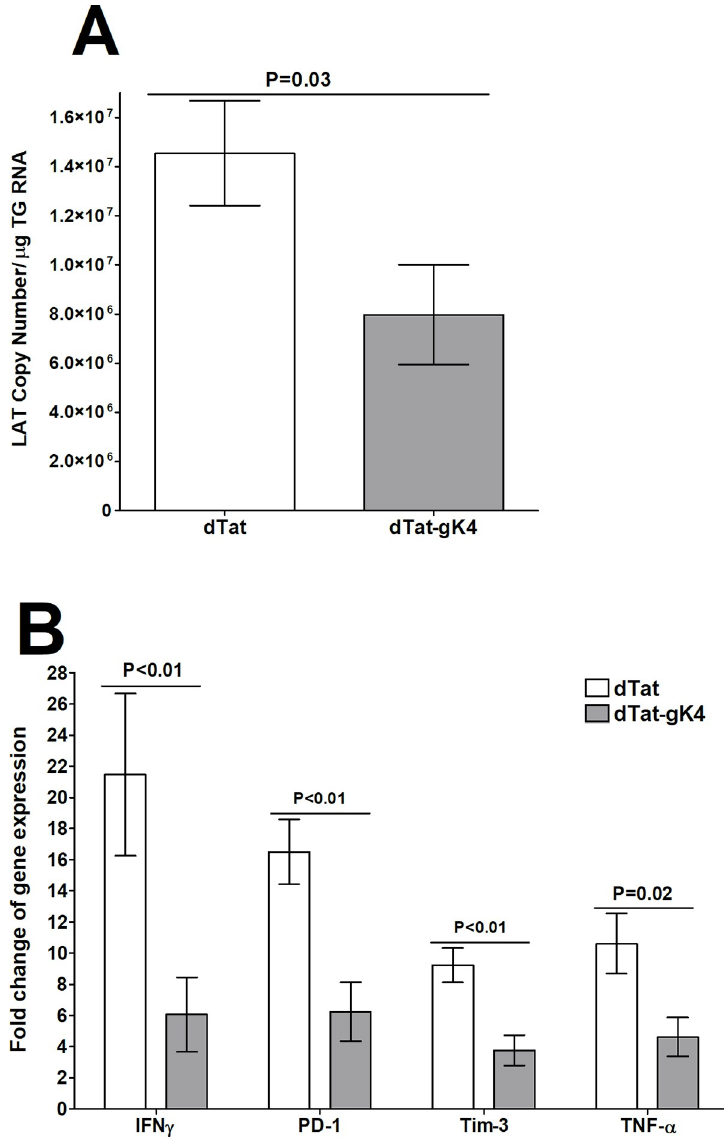
Fig 10. Effect of dTat-gK4 peptide on latency and exhaustion marker levels in C57BL/6 infected mice. TG from mice described in Fig 9 legend were harvested on day 28 PI. Total RNA from each TG was isolated as described in Materials and Methods. A) Quantitation of LAT RNA in TG of immunized mice. Quantitative RT-PCR was performed on each mouse TG. In each experiment, an estimated relative copy number of HSV-1 LAT was calculated using standard curves generated from pGem5317. Briefly, DNA template was serially diluted 10-fold such that 1 μ l contained 10 3 to 10 11 copies of LAT, then subjected to TaqMan PCR with the same primer set. By comparing the normalized threshold cycle ( C T ) of each sample to the threshold cycle of the standard, copy number for each reaction was determined. GAPDH expression was used to normalize relative expression of viral LAT RNA in TG. Each bar represents the mean ± SEM from 22 TG for dTat-gK4 treated mice and 18 TG for dTat control group. B) qRT-PCR analyses of IFN γ , PD-1, Tim-3, and TNF- α transcripts in TG of latently-infected mice. Total RNA described above from each individual TG was used to estimate relative expression of IFN γ , PD-1, Tim-3, and TNF- α transcripts in TG of mice in dTat-gK4 treated or dTat control group. The expression ratio of each mRNA in the TG was normalized to its expression in TG of uninfected control mice. GAPDH expression was used to normalize relative expression of each transcript in TG of immunized mice. Each bar represents the mean ± SEM from 12 TG for each group. Panels: A) LAT; and B) Exhaustion